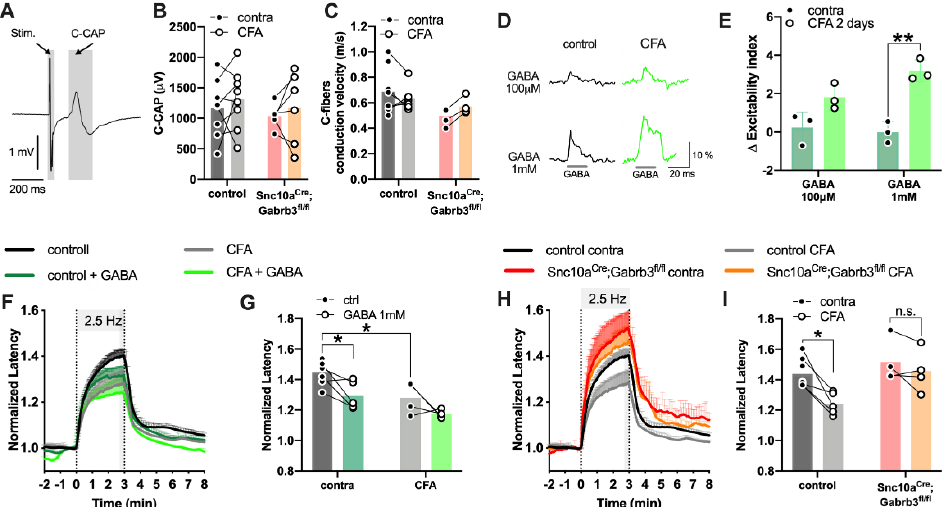
Figure 7. ( A ) Example sural nerve C-fibre compound action potential (C-CAP). C-CAP amplitude ( B ) and axonal conduction velocity ( C ) were not altered between sham injected contralateral (closed markers, ( B , C )) and injected sides 2 days after CFA (open markers, ( B , C )) in littermate controls (black and grey bars, ( B , C ), n = 7) and Scn10a Cre ; Gabrb3 fl/fl mice (red and orange bars, ( B , C ), n = 6). ( D ), In naïve wildtype mice, axonal responses to GABA at 100 µ M (upper traces, ( D )) and 1 mM (lower traces, ( D )) are increased 2 days after CFA inflammation (green traces, ( D )). ( E ) Pooled data for the change in axonal GABA response amplitude in contralateral sural nerves (dark green bars, ( E ), n = 3) and 2 days after CFA injection (light green bars, ( E ), n = 3). ( F ) Electrical stimulation at 2.5 Hz for 3 min (grey shading, ( F ) resulted in activity-dependent slowing (ADS) of axonal conduction velocity measured as an increase in C-CAP latency (Normalized latency, ( F )). ( G ) Effect of GABA (1 mM, green, ( F )) on ADS (Normalized latency, ( G )) in the untreated contralateral sural nerve (contra, ( G ), n = 6) and CFA injected side (CFA, ( G ), n = 3). H, ADS in Scn10a Cre ; Gabrb3 fl/fl (red, ( H )) and littermate control mice (black, ( H )) before (black and red, ( H )) and 2 days after CFA (grey and orange, ( H )). ADS was reduced after CFA (open markers and grey bar, ( I ) in control mice ( n = 5) but not in Scn10a Cre ; Gabrb3 fl/fl mice (red and orange bars, ( I ), n = 4). Values of p < 0.05 were considered significant and are indicated with asterisks as follows; * p < 0.05 and ** p < 0.01, n.s. = not